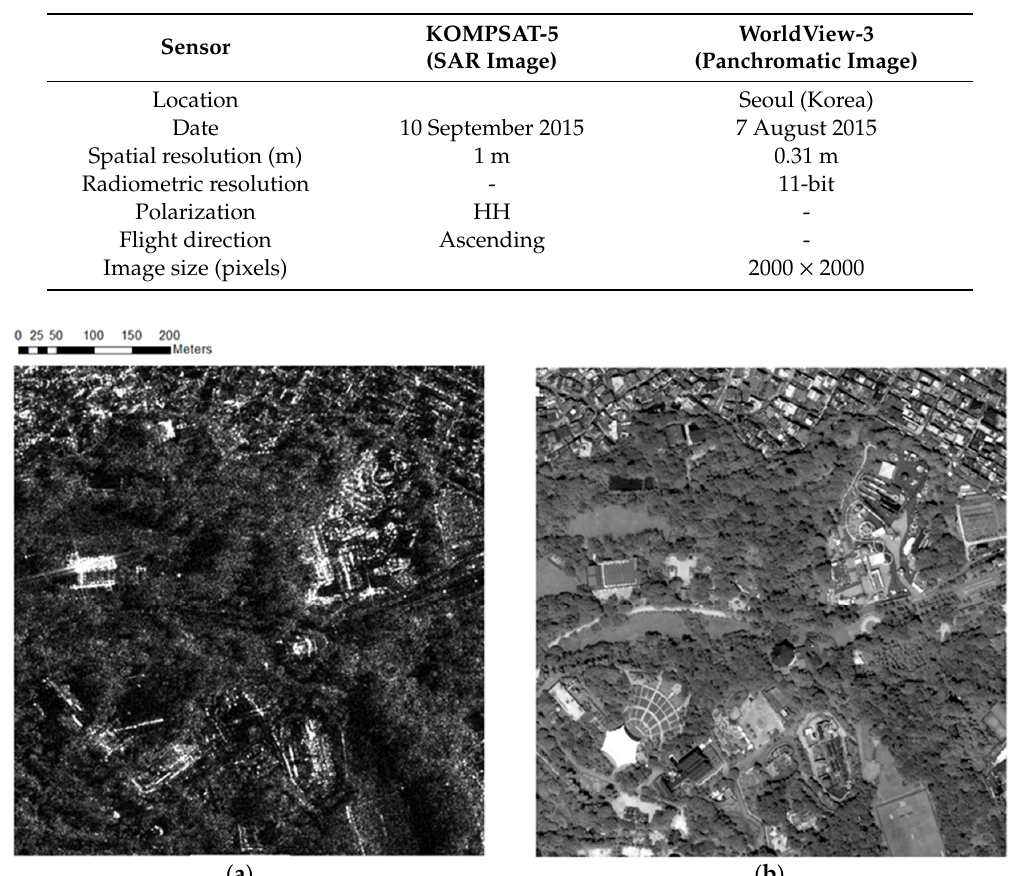
Figure 2. Experimental images from Site 1: ( a ) synthetic aperture radar image acquired on 10 September 2015; and ( b ) panchromatic image acquired on 7 August 2015.